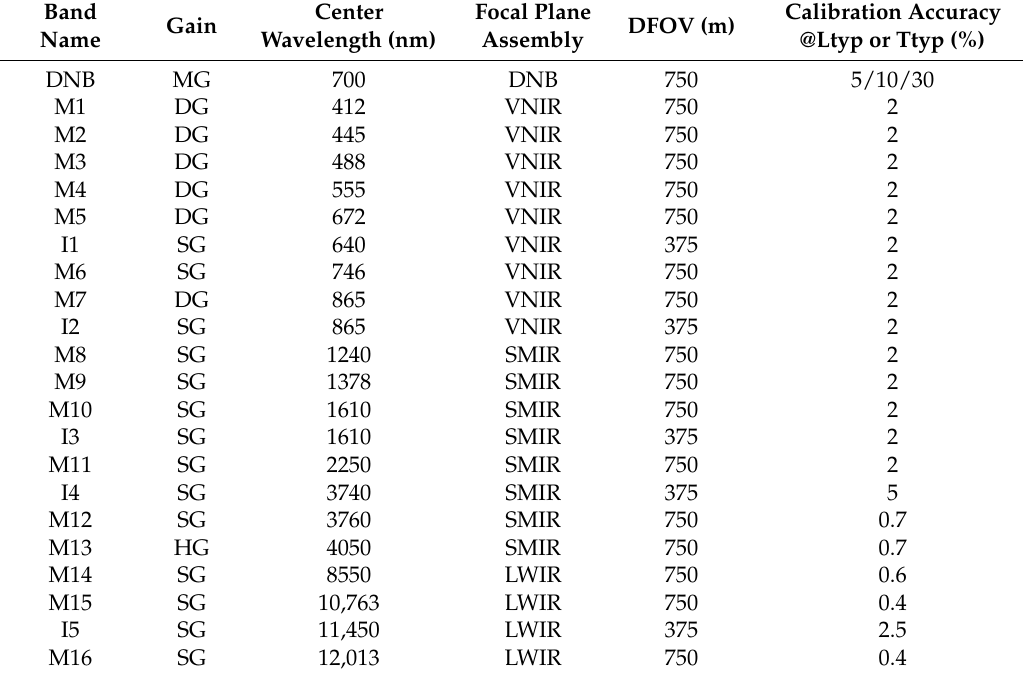
Table 1. The Visible Infrared Imaging Radiometer Suite (VIIRS) Spectral, Spatial and Radiometric Specifications at Typical Scenes (Ltyp or